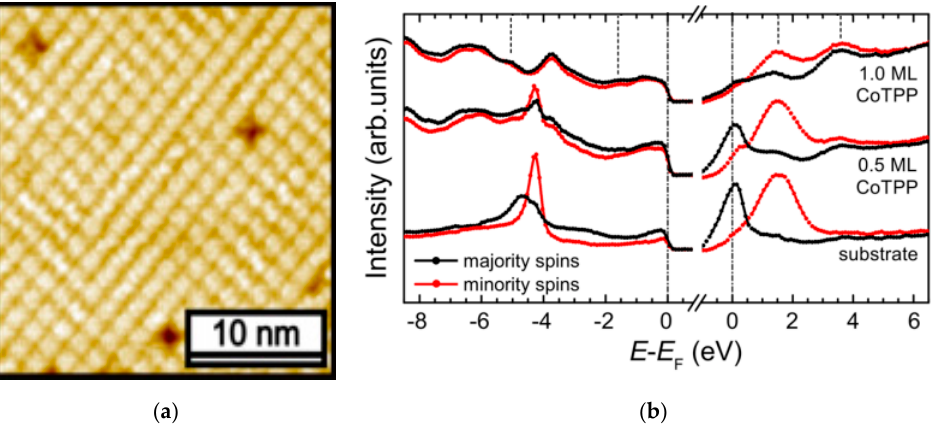
Figure 1. ( a ) Scanning tunneling microscopy (STM) image acquired on 1 monolayer (ML) of CoTPP on Fe(001)- p (1 × 1)O. ( b ) Spin-resolved photoemission spectroscopy (SR-PES) and inverse photoemission spectroscopy (SR-IPES) spectra for different CoTPP coverages on Fe(001)- p (1 × 1)O. The majority and minority labels refer to the substrate